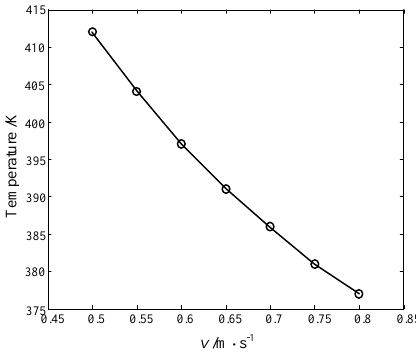
Figure 5. Flow velocity and hot-spot temperature rise.